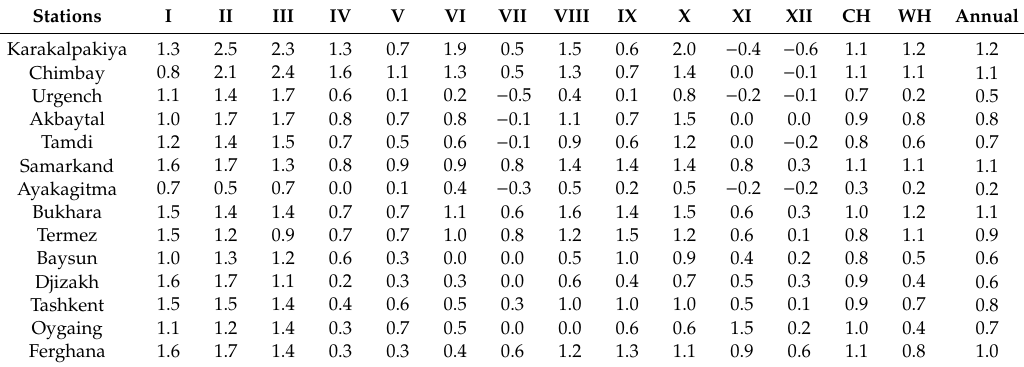
Table A2. Long-term mean air temperature ( ◦ C) at the representative stations of Uzbekistan for the present period (1991–2016) compared to the baseline climatic period (1961–1990) by month. CH—Cold Half-Year (November–April), WH—Warm Half-Year (May–October).